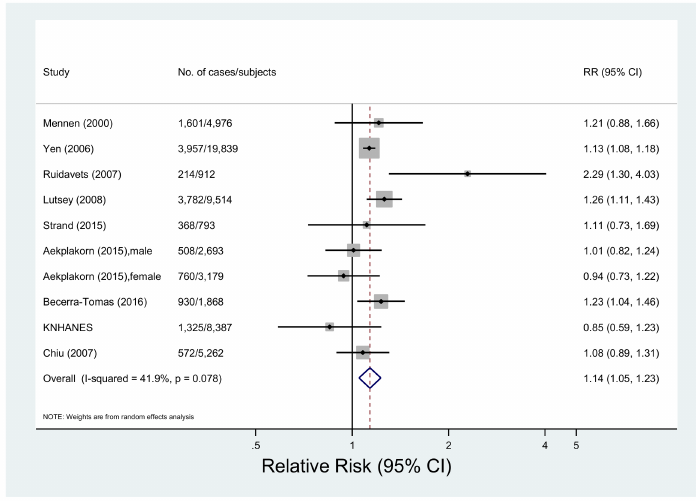
Figure 2. Forest plot of observational studies of metabolic syndrome for the highest vs. lowest levels of total meat consumption, using a random-effects model. Table 2. Summary of pooled relative risks for meat consumption and risk of metabolic syndrome for highest vs. lowest meat